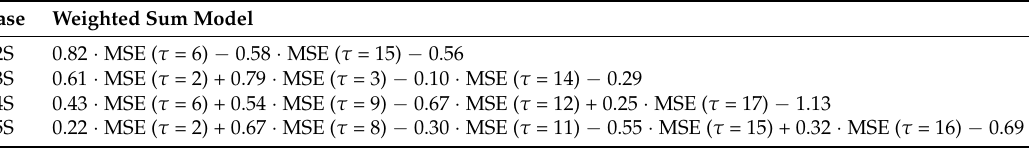
Table 3. The weighted sum models for the 2S–5S cases.